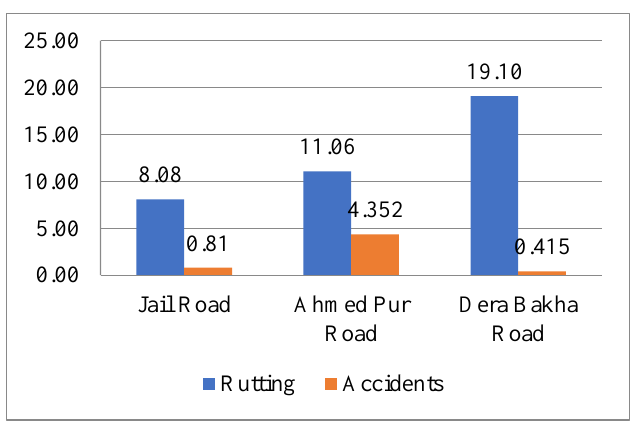
Fig. 11 Bar chart comparing rutting and accident data (1/1000 scale)